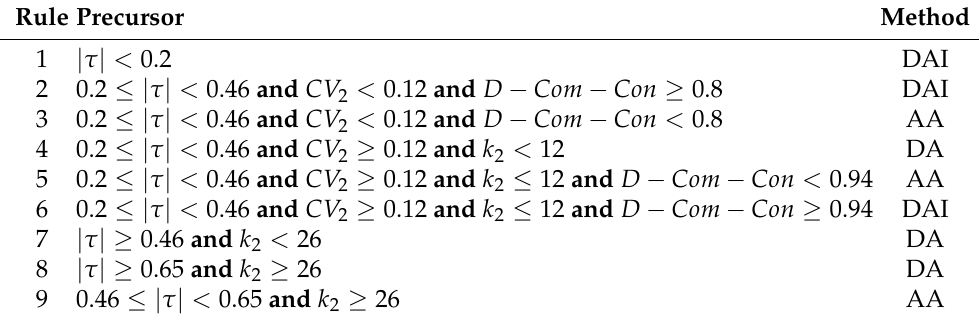
Table 6. Extracted decision rules.